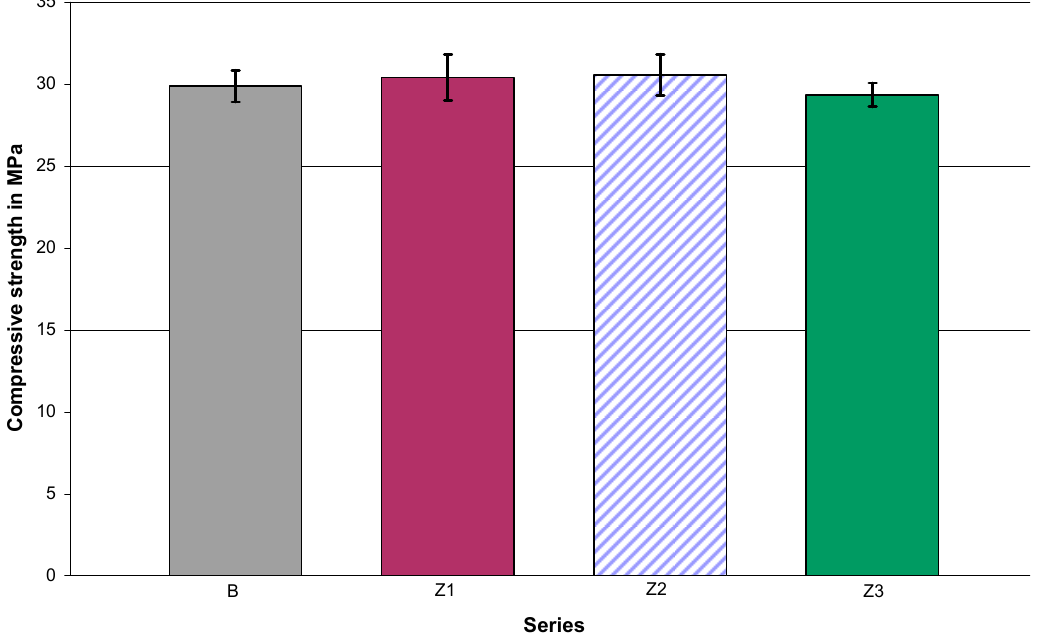
Figure 7. Results of the compressive strength tests for the concrete without the scattered reinforcement and the concrete with the scattered reinforcement in the form of PET fibres.